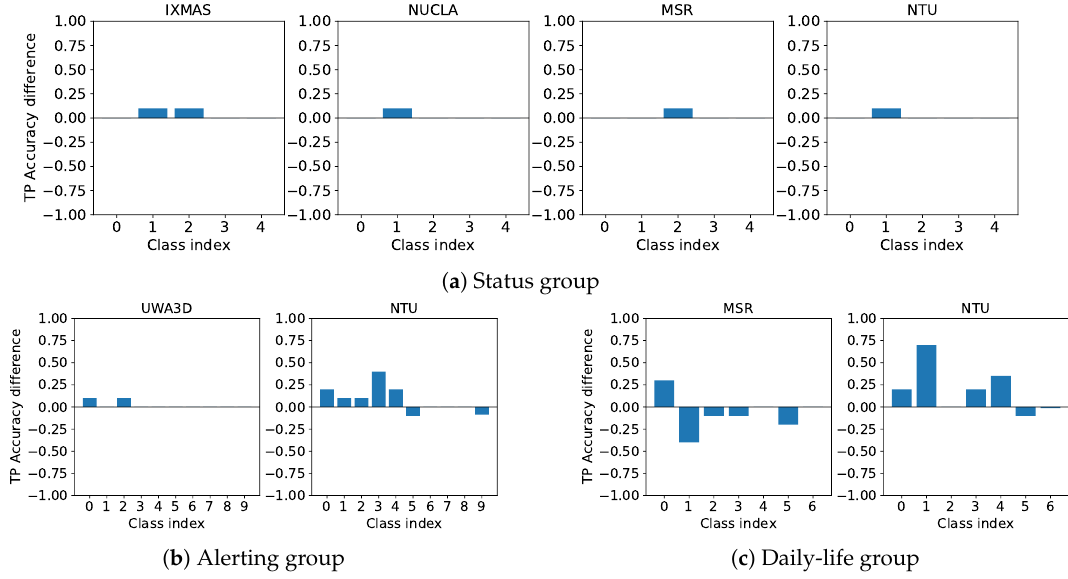
Figure 5. True prediction accuracy difference for each group, between standard merged dataset and the same dataset with the addition of 200 samples from NTU for each action where provided. Charts omitted if there are no differences for the specific dataset. Positive values represent the percentage increment of accuracy, negative values the deterioration of